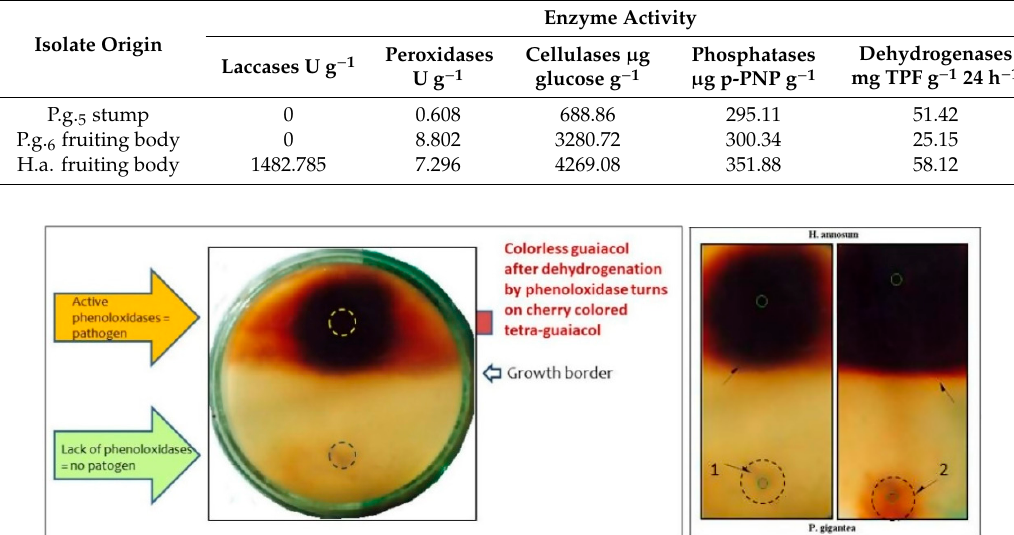
Figure 7. Average loss (%) of dry weight from Norway spruce wood after 6 months of decomposition, caused by six H. parviporum and two Finnish P. gigantea isolates (Tukey test, p α = 0.05) ( Ż ó ł ciak et al.